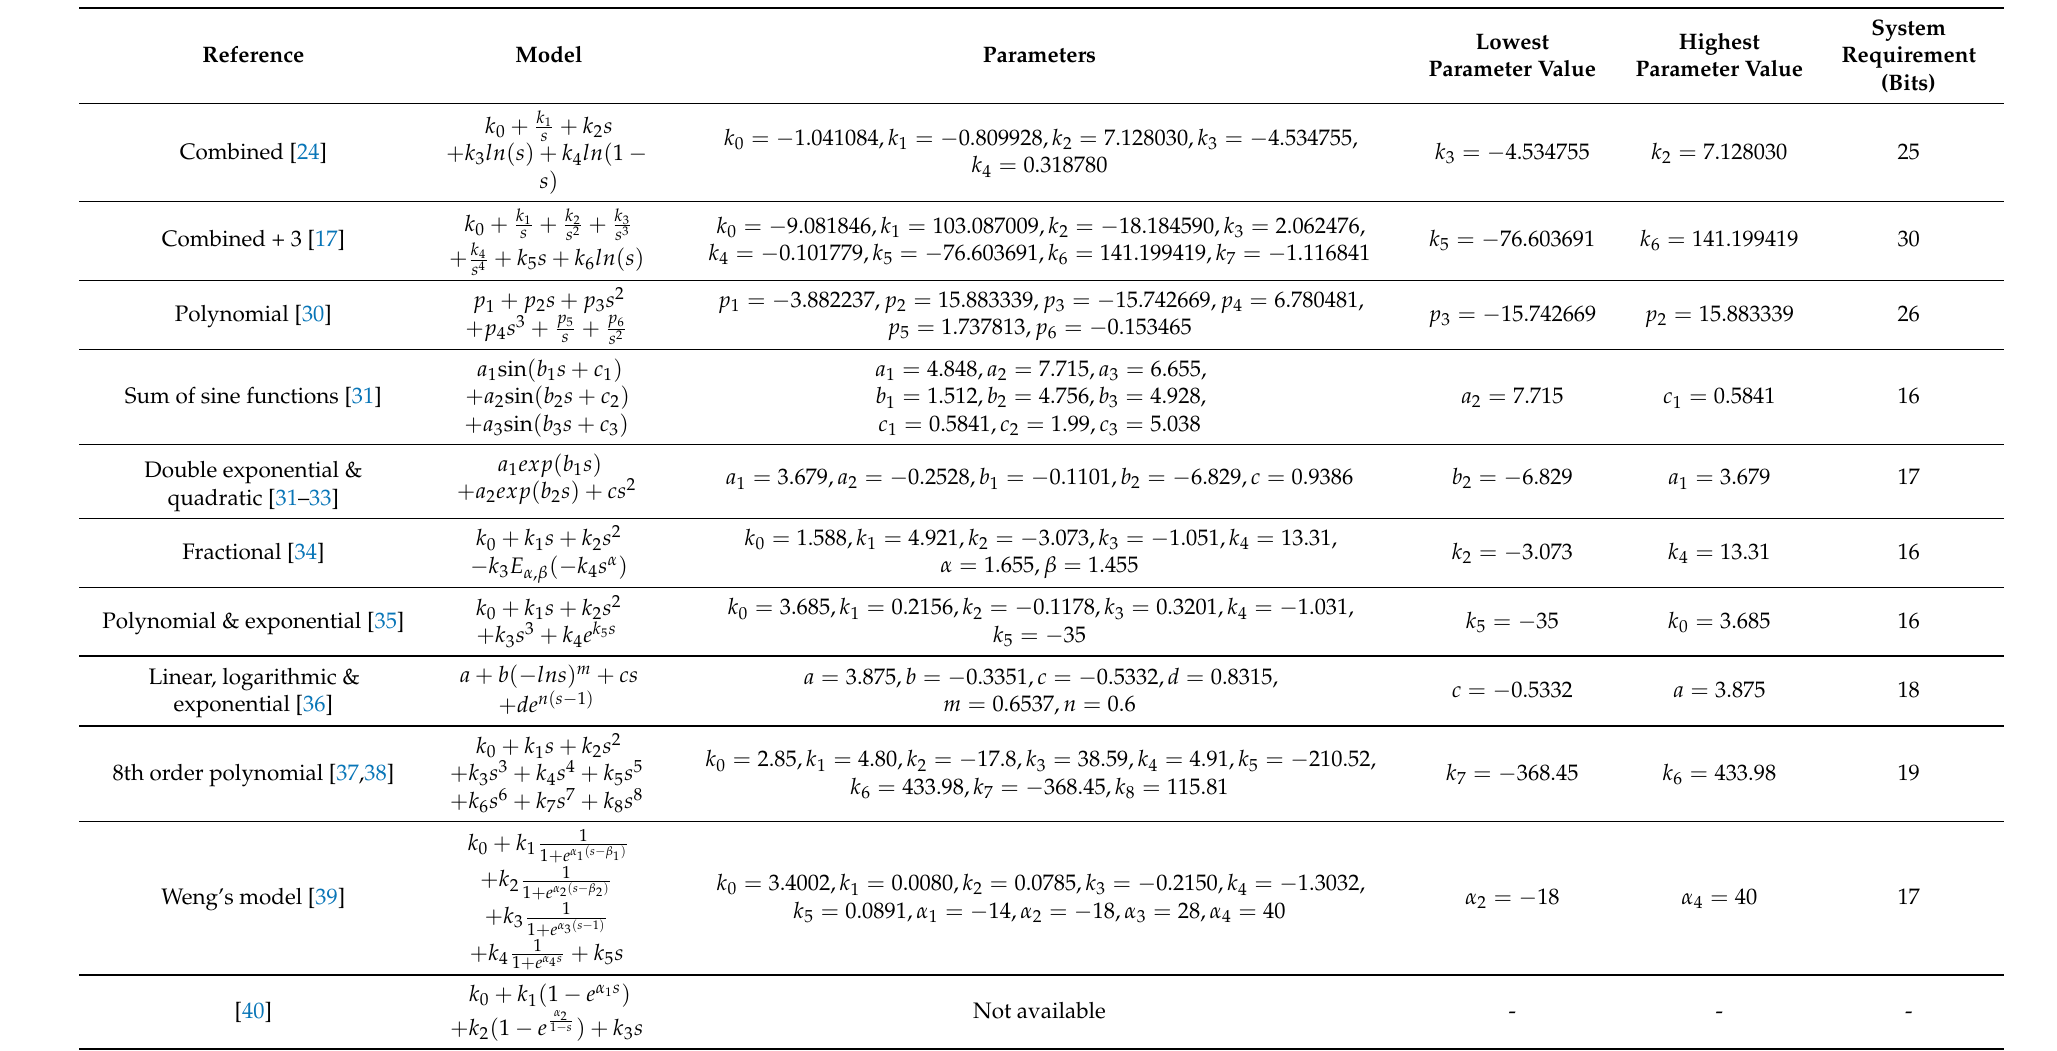
Table 1. Overview of existing models in the